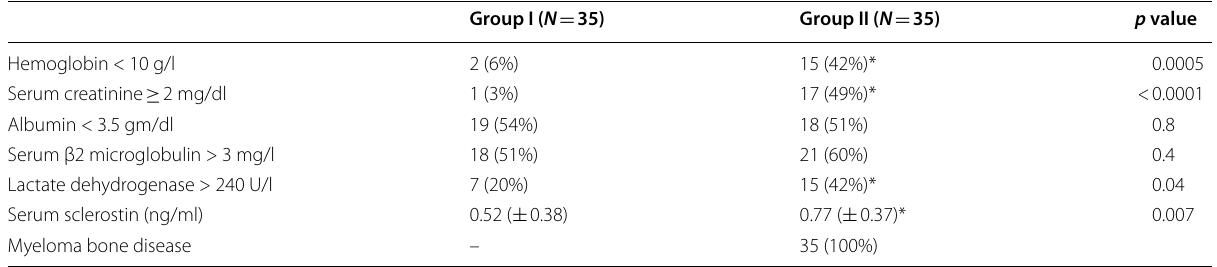
*Significant comparing group I group II